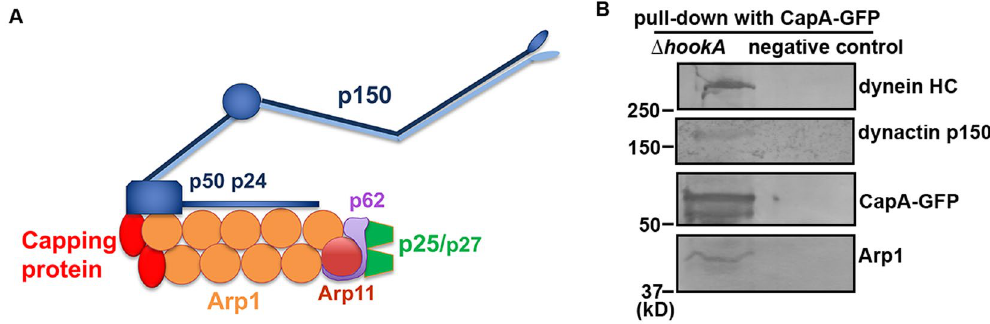
Figure 1. Components of the dynactin complex are pulled down with CapA-GFP. ( A ) A schematic representation of the dynactin complex. Conventional actin was not depicted as we do not have evidence from our pull-down experiments that conventional actin is a component of the A . nidulans dynactin complex. ( B ) Western blots showing that dynactin p150, Arp1 and the dynein HC were pulled down with CapA-GFP. A strain without any GFP tag was used as a negative control. Cropped pieces with black outlines indicate blots probed by different antibodies against the indicated proteins (see Supplemental Fig. 5 for the original blots). The antibody against GFP (from Clontech) has been used previously 29 . The affinity-purified antibodies against dynein HC, dynactin p150 and Arp1 have been described and used previously 6,40